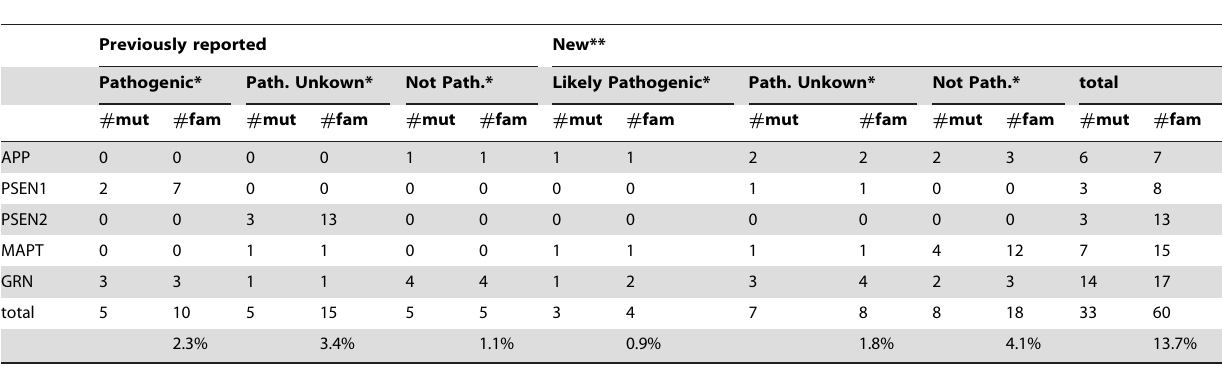
Table 3. Number of rare non-synonymous and splice-site variants found in the 439 sequenced samples.